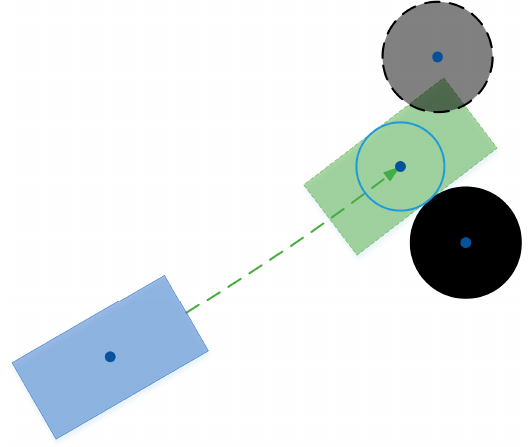
Figure 4. Schematic diagram of the challenge of the circle model.